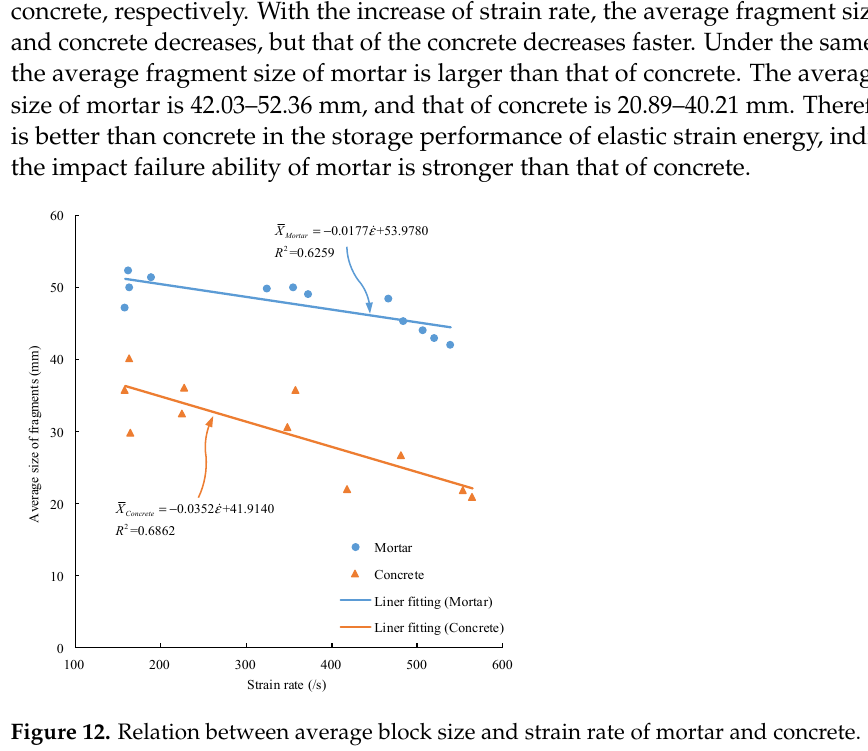
Figure 12. Relation between average block size and strain rate of mortar and